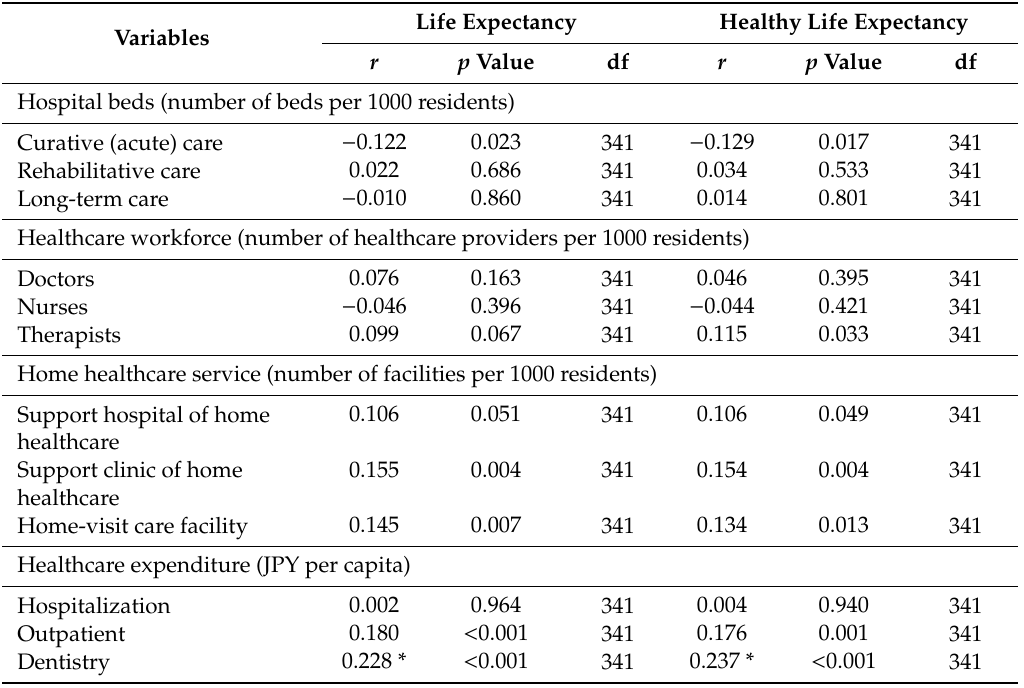
Table 3. Associations between healthcare resources, life expectancy, and healthy life expectancy at birth for males.